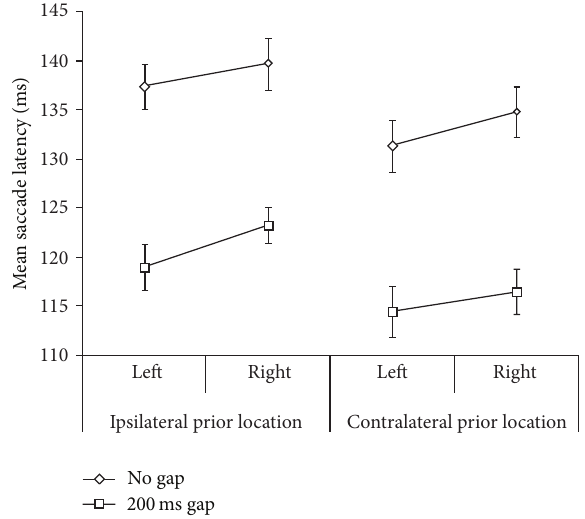
Figure 6: Mean saccadic latencies for the three-way interaction of gap × prior location × direction from fixation. Error bars = ± 1 SEM.